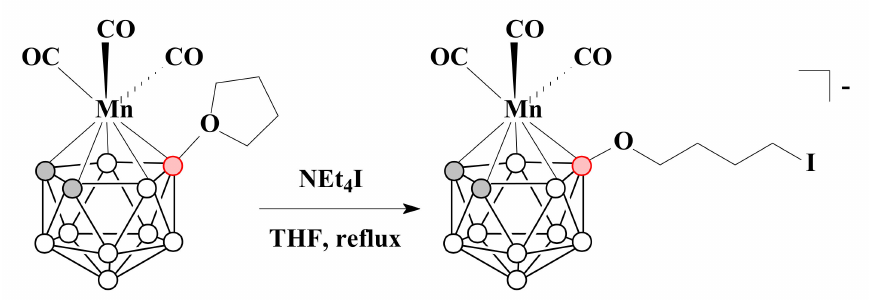
Scheme 23. The reaction of [3,3,3-(CO) 3 -3-Mn(8-(CH 2 ) 4 O-1,2-C 2 B 9 H 10 )] with NEt 4 I. The treatment of [3,3,3-(CO) 3 -3-Mn(8-(CH 2 ) 4 O-1,2-C 2 B 9 H 10 )] with donor molecules such as PPh 3 , NEt 3 and 4-methylpyridine in THF at room temperature gave the correspond- ing charge-compensated complexes [3,3,3-(CO) 3 -3-Mn(8-L-CH 2 (CH 2 ) 3 O-1,2-C 2 B 9 H 10 )] (L = PPh 3 , NEt 3 , 4-Me-C 5 H 4 N) [89] (Scheme 24).